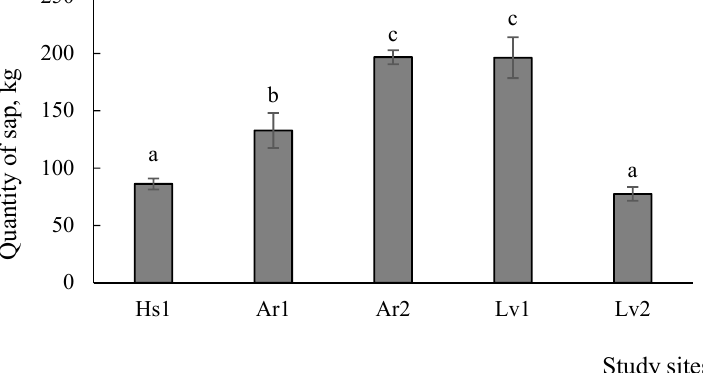
Figure 4. The mean quantity of sap harvested from silver birch ( Betula pendula ) forest stands growing in different soils. Abbreviations: Hs1—Histosol; Ar1 and Ar2—Arenosol; Lv1 and Lv2—Luvisol. The results are expressed as the mean ± SE, and different lowercase letters indicate signi fi cantly different ( p < 0.05) means based on Tukey’s test.